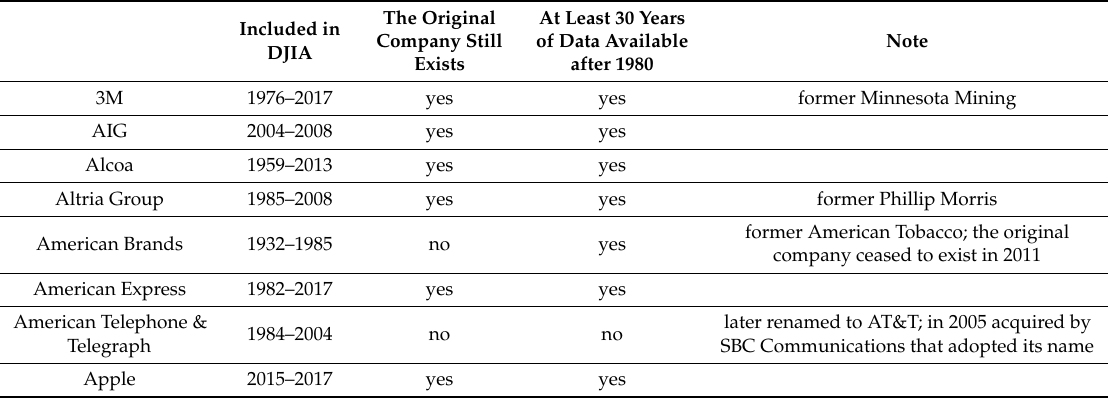
Table A1. Selection of the analyzed